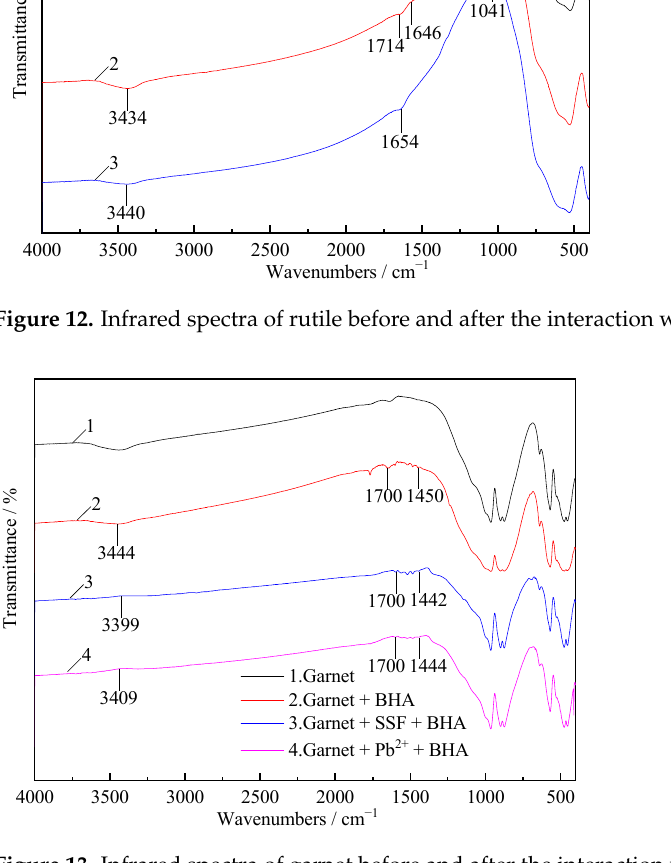
Figure 12. Infrared spectra of rutile before and after the interaction with reagents.